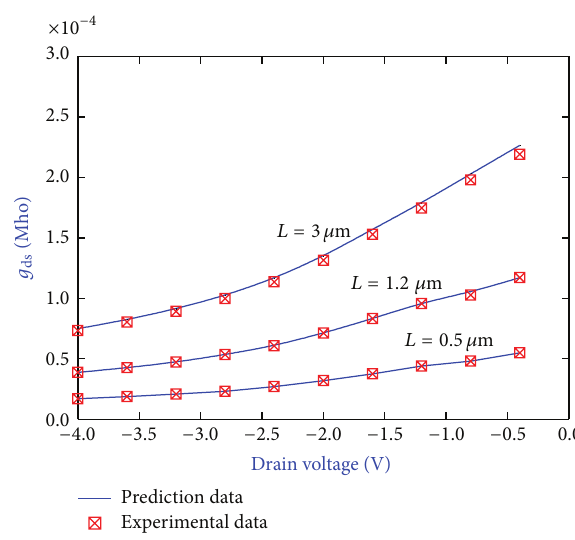
Figure 6: Comparison of 𝐼 𝑑 measured results and training predic- tion data of the group 1A samples (as 𝑉 𝑔 = −2 , − 4V; 𝑉 𝑑 = −3 V).